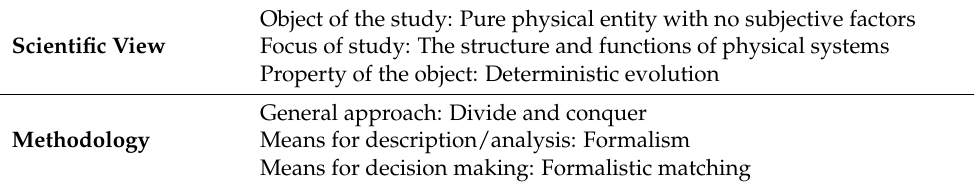
Table 1. Major features of the paradigm of the physical disciplines.